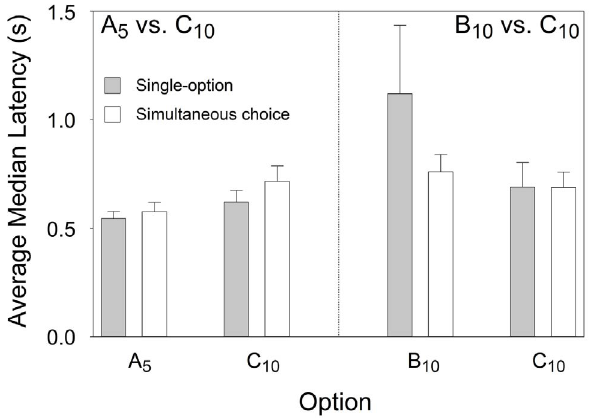
Figure 7. Latencies to accept each option in single-option and simultaneous choice trials. Latencies are separated according to collection time: either at stability in the A 5 vs. C 10 preference tests or at stability in the B 10 vs. C 10 preference tests. Grey and white bars present median latencies averaged across subjects ( + SE) from single-option and simultaneous choice trials,